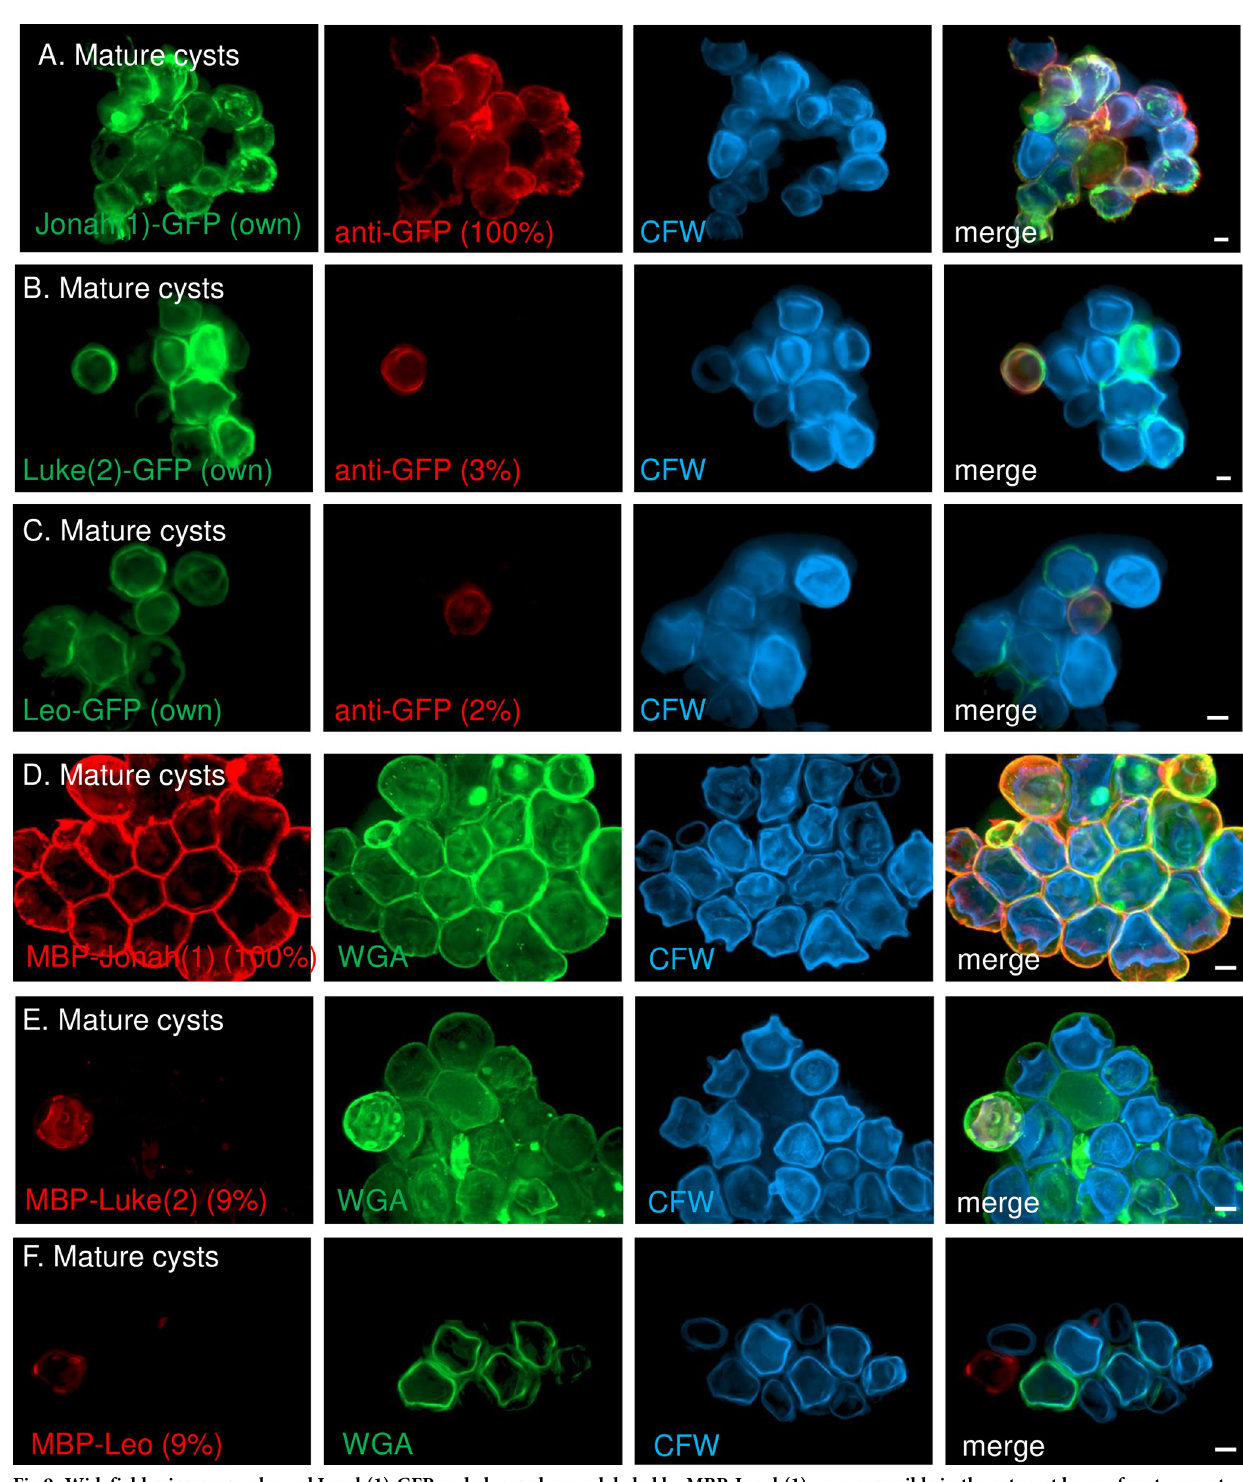
PLOS NeglectedTropical Diseases | https://doi.org/10.1371/journal.pntd.0007352 May 16,